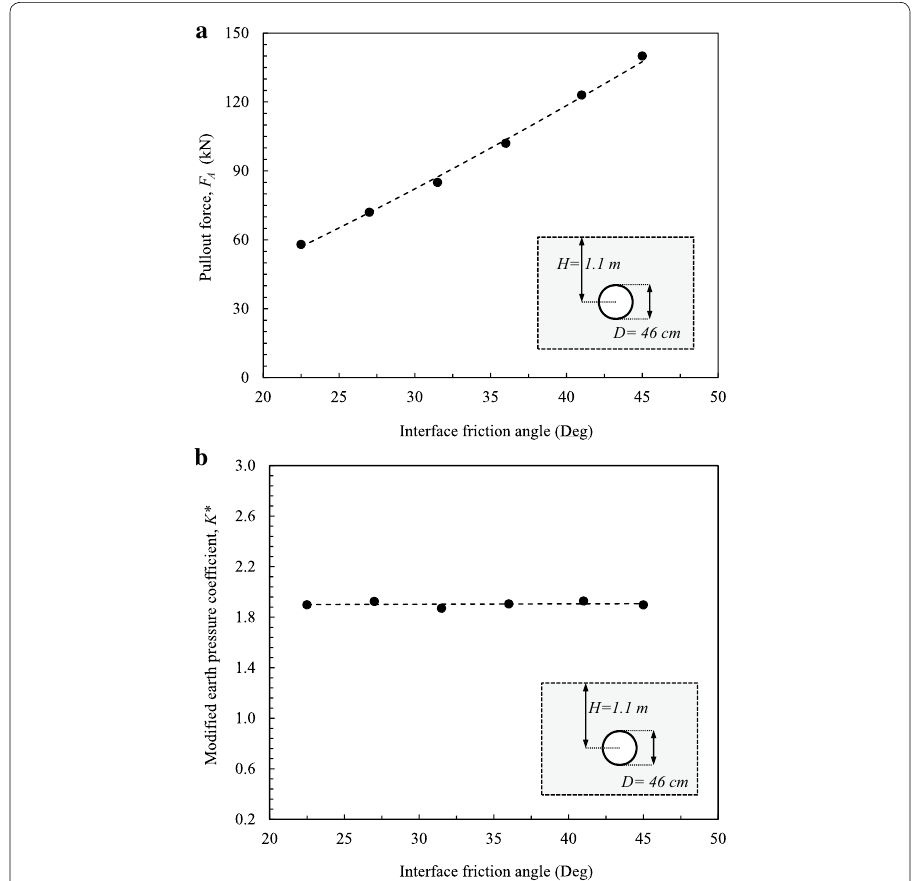
Fig. 9 Effect of interface friction angle a pullout force; b modified earth pressure coefficient